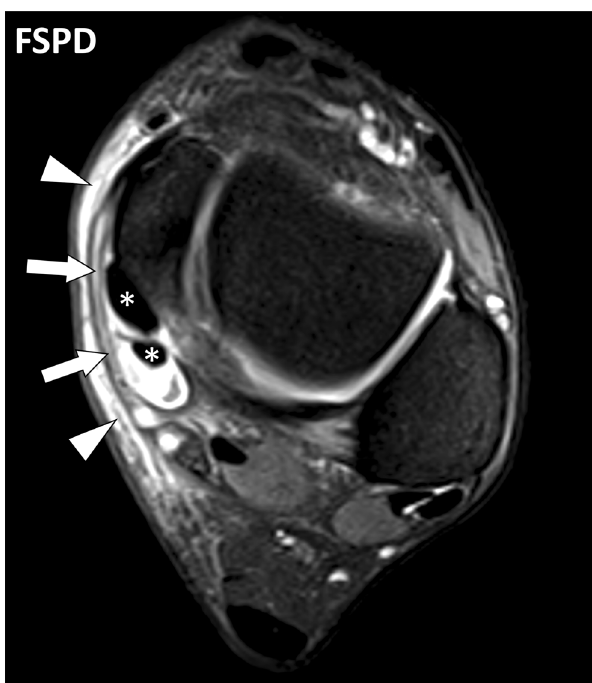
Fig. 13 Axial FSPD-weighted image of the ankle of a 54-year-old male with psoriatic arthritis. Involvement of the flexor retinaculum (arrows) and subcutaneous fat(arrowheads) withthickening andfluid-like signalis associated with effusion of the synovial sheath (tenosynovitis) of the tibialis posterior and flexor digitorum longus tendons